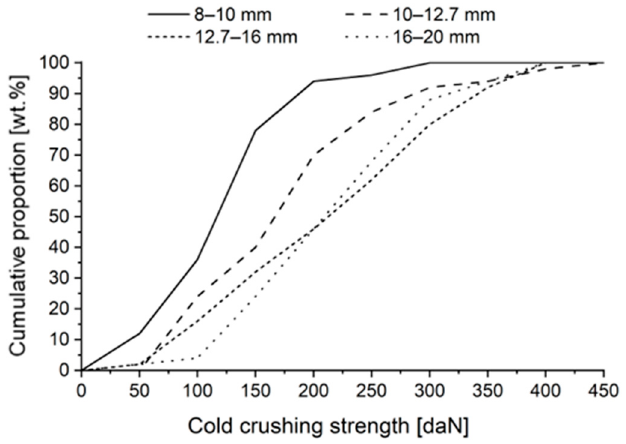
Figure 12. Cumulative CCS distribution curves for different-sized pellets.